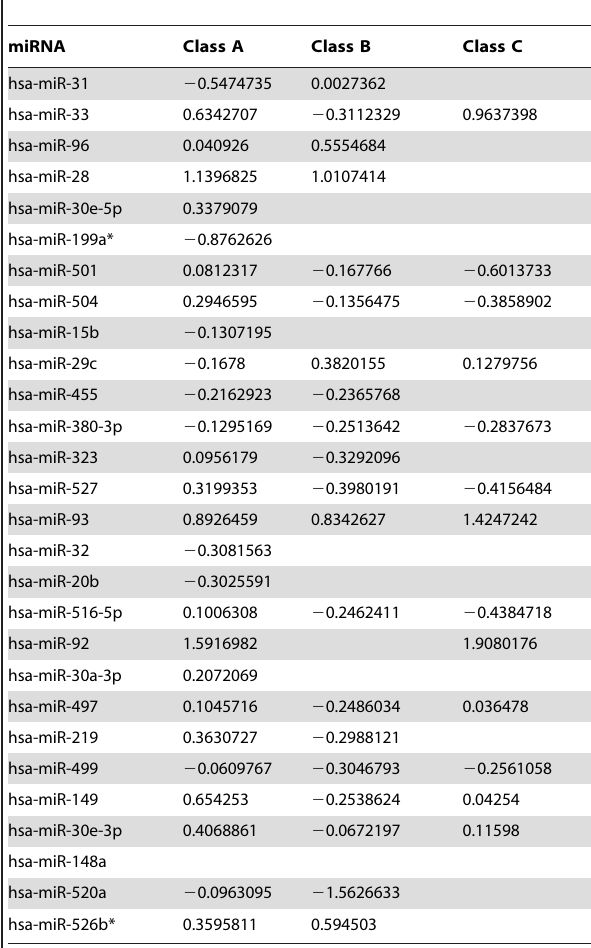
Table 6. Covariate effects of medications on highly-ranked miRNAs in SAM (top-21 in Table 2 and top-12 in Table